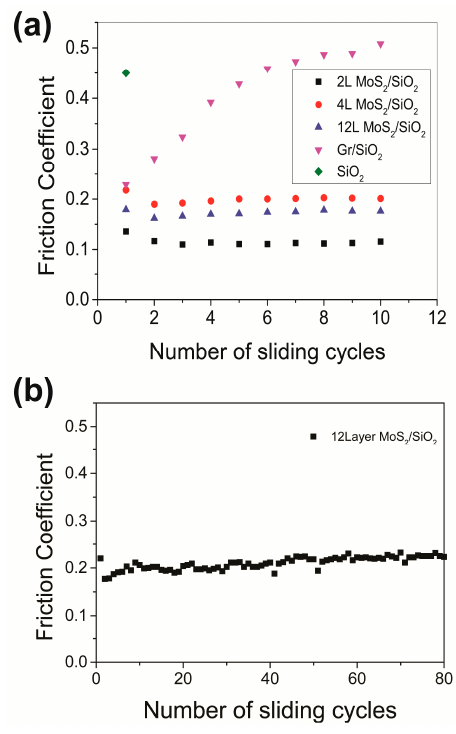
Figure 2. Coefficients of friction determined under low pressure for ( a ) 2L MoS 2 , 4L MoS 2 , 12L MoS 2 , and 1L graphene subjected to up to 10 cycles of sliding and SiO 2 /Si subjected to up to 1 cycle and for ( b ) 12L MoS 2 subjected to up to 200 cycles of sliding.